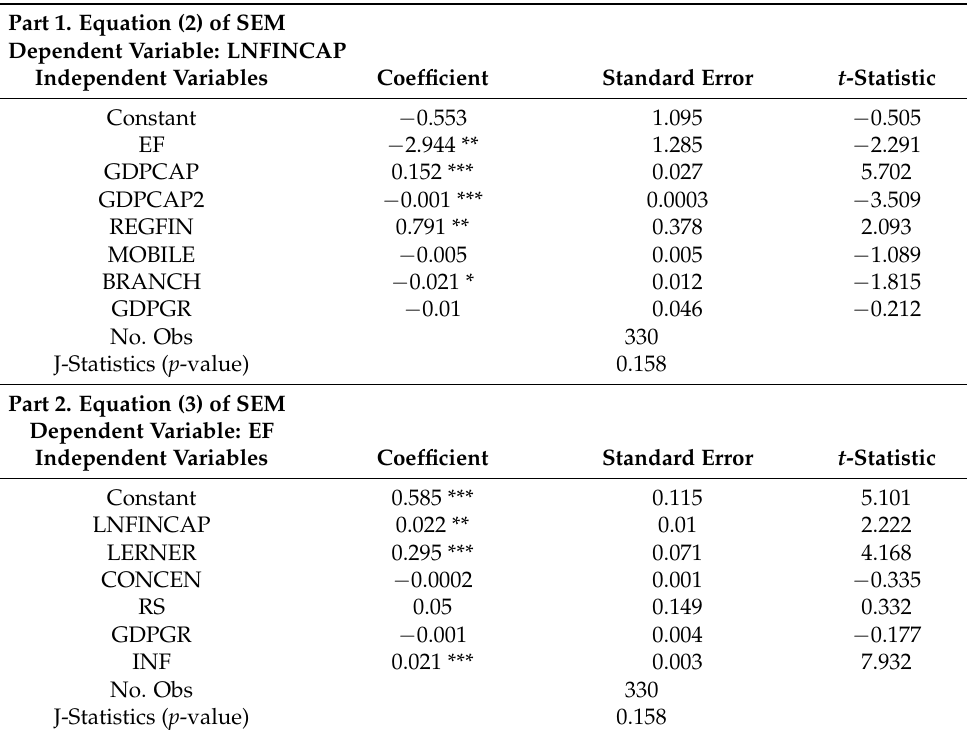
Table 2. Results of second-stage SEM